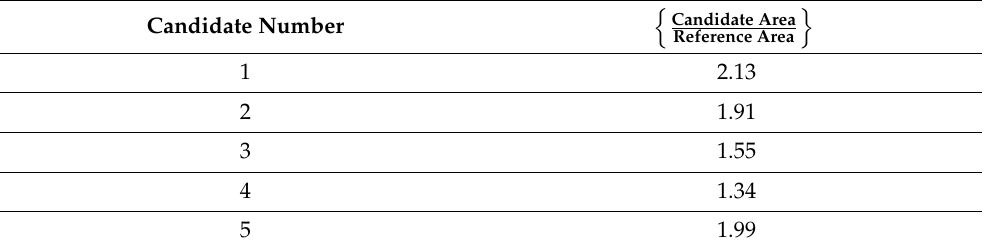
Table 4. Comparison of the different candidates’ performances as compared with the reference (no-ridge) cases as in Figure